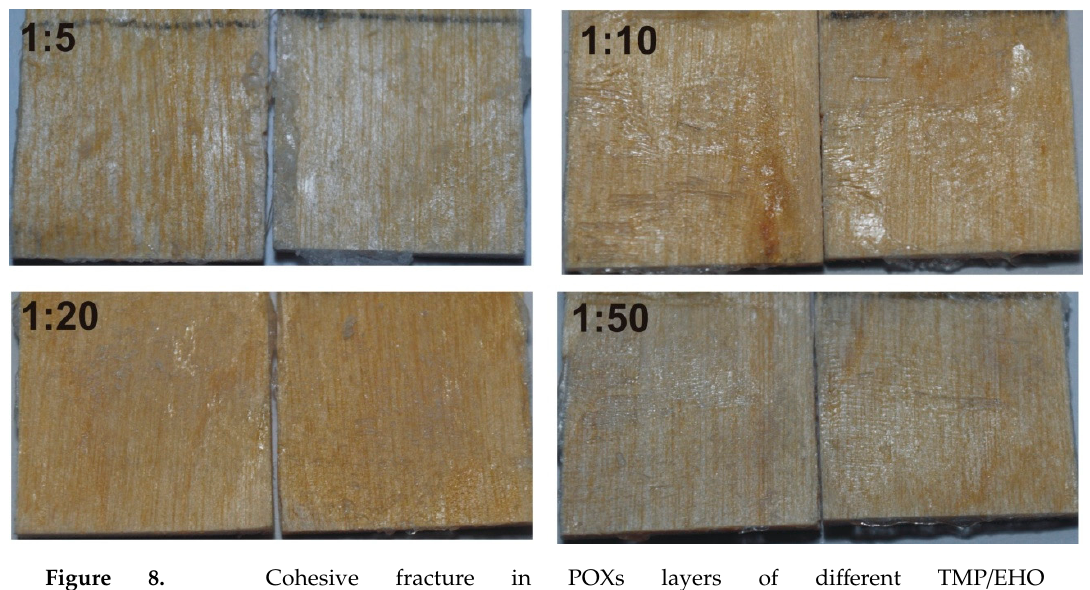
Figure 7. Shear strengths of the POX bond-lines.